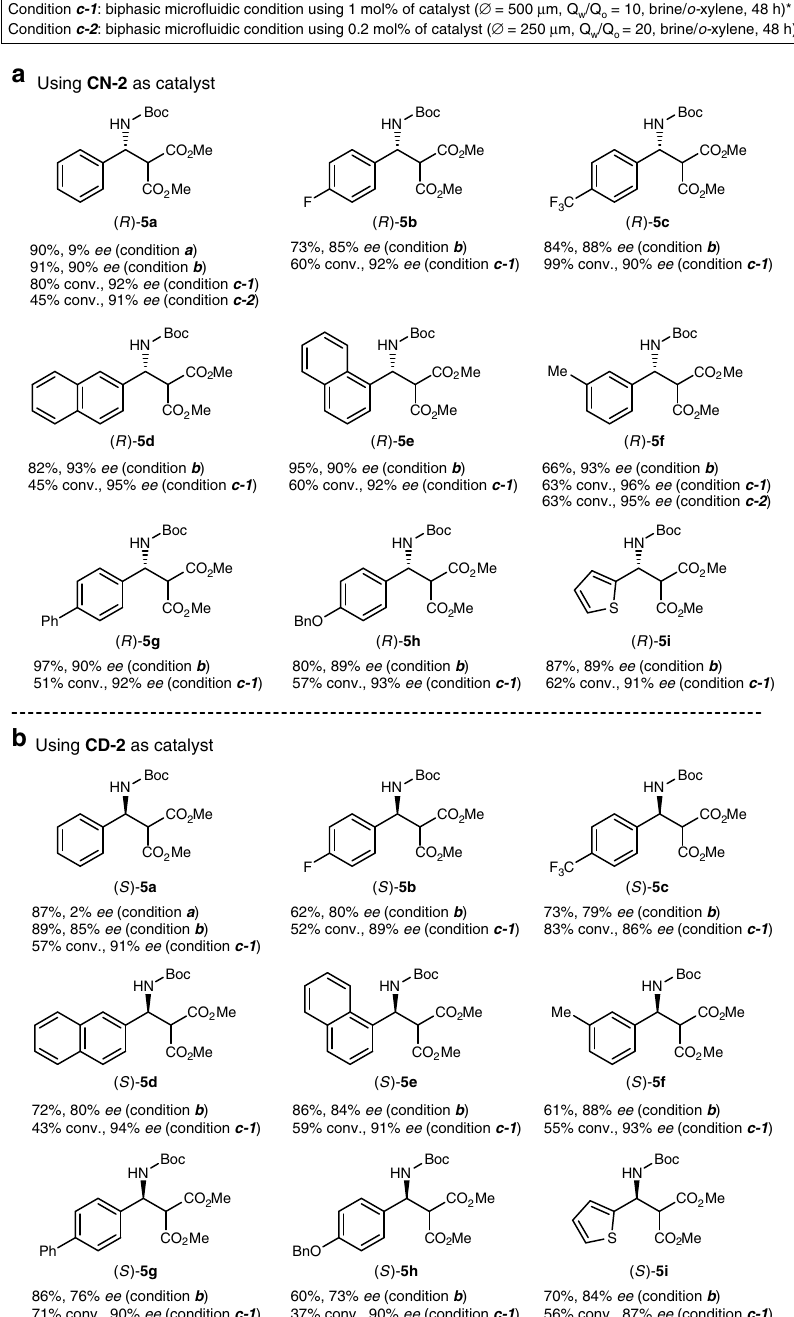
Fig. 5 Substrate generality of water-induced hydrophobic chirality ampli fi cation in the Mannich reaction. a Using CN-2 as catalyst. b Using CD-2 as catalyst. *The isolated yields could not be determined since the total amount (~240 μ L) of organic reaction mixture in the micro-tube was too small to determine the correct yield. We, thus, determined the conversion by 1 H NMR integration instead of the isolation yields. We assumed that the imine 1 can be converted to the corresponding product 5 since the nucleophile 4 was oversupplied (the molar ratio of 1 : 4 = 1:2), and the hydrolysis of 1 to aldehyde was negligible compared to the imine consumption by the